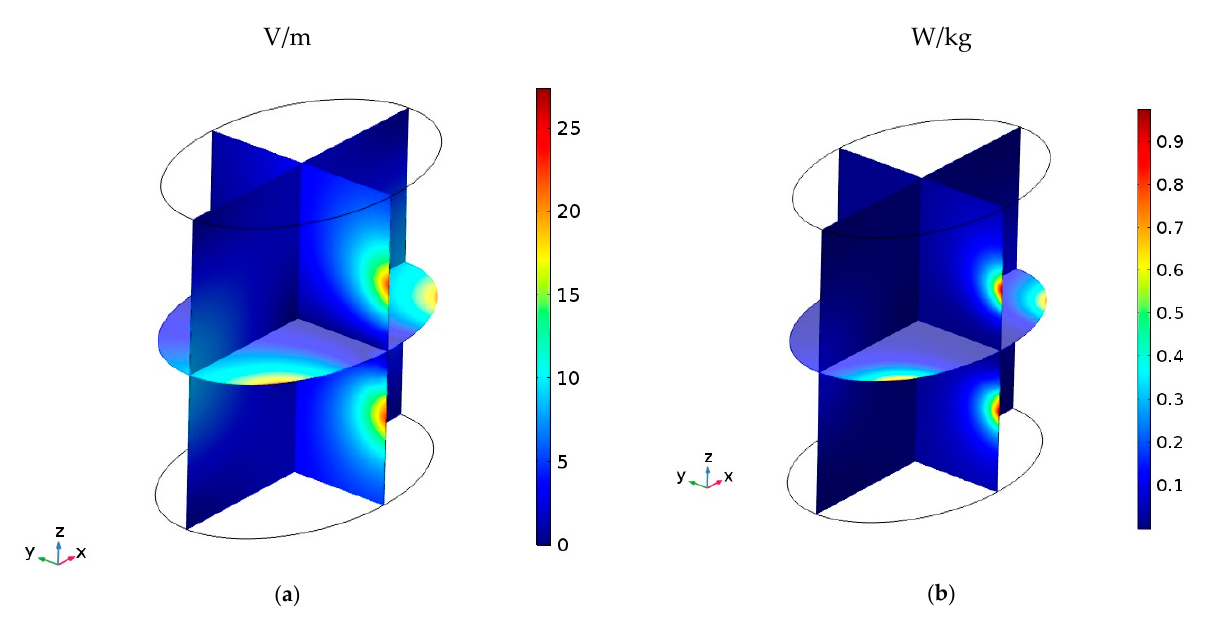
Figure 12. Distribution of electric field E ( a ) and SAR ( b ) inside the torso.